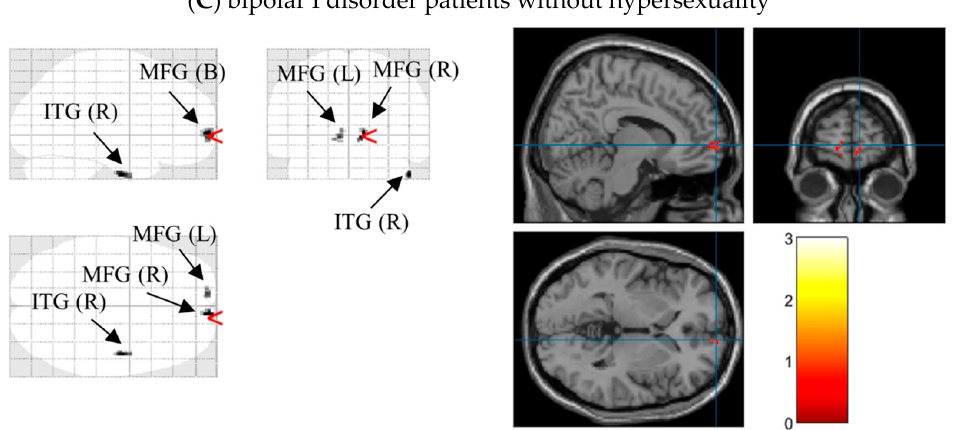
Figure 4. Source map of N1 (time window: 70~200 ms) to the target stimuli under Erotica in healthy volunteers ( A ), bipolar I disorder patients with ( B ) and without ( C ) hypersexuality (generated by xjView 10.0 (http://www.alivelearn.net/xjview (accessed on 10 March 2022)). Left panels show sources overlaid on a glass brain; Right panels show sources overlaid on a T1 template brain. The red arrowheads and blue cross hairs indicate source regions of peak intensity in the three groups were the right supramarginal gyrus, left postcentral gyrus, and right medial frontal gyrus, respectively. Notes: SMG (B), bilateral supramarginal gyri; LG (B), bilateral lingual gyri; IFG (L), left inferior frontal gyrus; PCG (L), left postcentral gyrus, SMG (R), right supramarginal gyri; IFG (R), right inferior frontal gyrus; MFG (B): bilateral medial frontal gyri; ITG (R), right inferior temporal gyrus. The bar in each panel on the right side indicates the intensity of cerebral activities, with white as the highest and black the lowest.